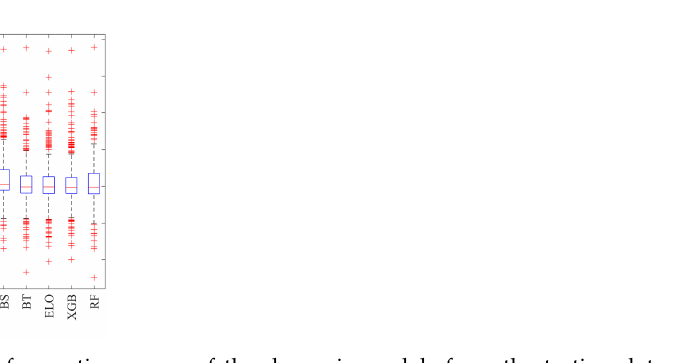
Figure 11. Distribution of forecasting errors of the dynamic models from the testing datasets: ( a ) France, ( b ) Turkey, and ( c ) Kaggle.